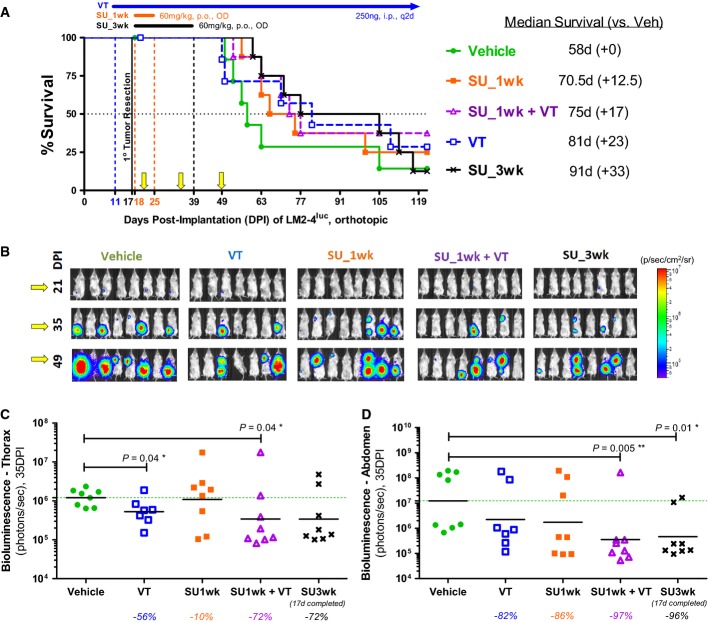
Combining perioperative Vasculotide treatment with adjuvant sunitinib treatment after surgical resection of LM2-4luc primary tumors

A Kaplan–Meier survival curves. Number of days gained in median survival due to treatments is listed in brackets. Yellow arrows mark the timepoints at which the bioluminescent images were taken.

B Bioluminescent images of tumor burden.

C–D Total bioluminescent fluxes, at 35 days post-implantation (while the ‘SU_3 wk’ group was still receiving 60 mg/kg/day sunitinib treatment), were separately quantified from the thoracic (C) and abdominal (D) regions. Geometric means and P values from Mann–Whitney tests are depicted in (C and D). Percentages listed below the x-axes in panels (C and D) refer to treatment-associated changes in the geometric mean bioluminescence, relative to the vehicle group.